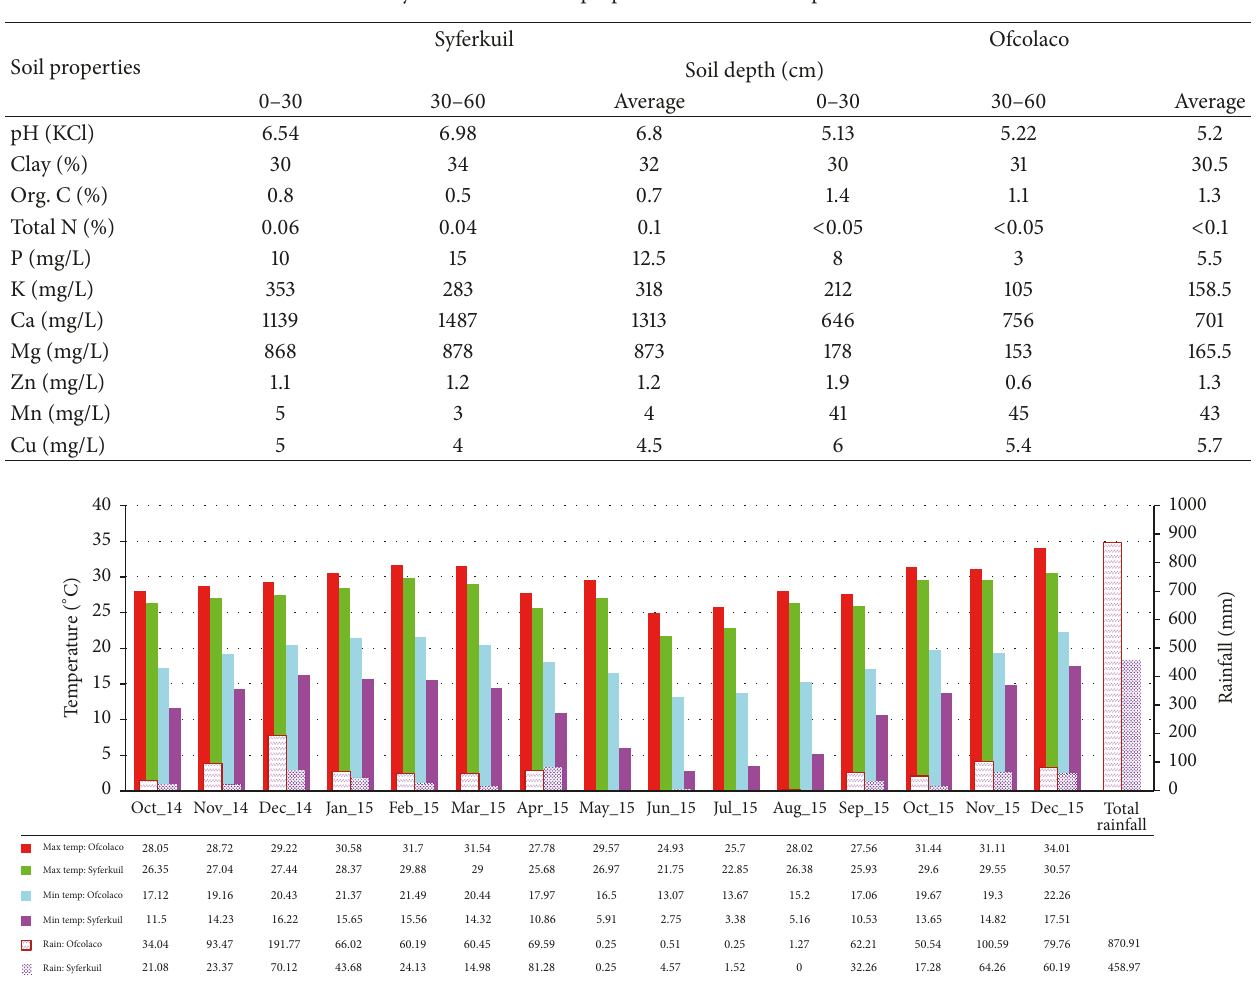
Figure 1: Weather data recorded during the 2014 and 2015 field trials at Syferkuil and